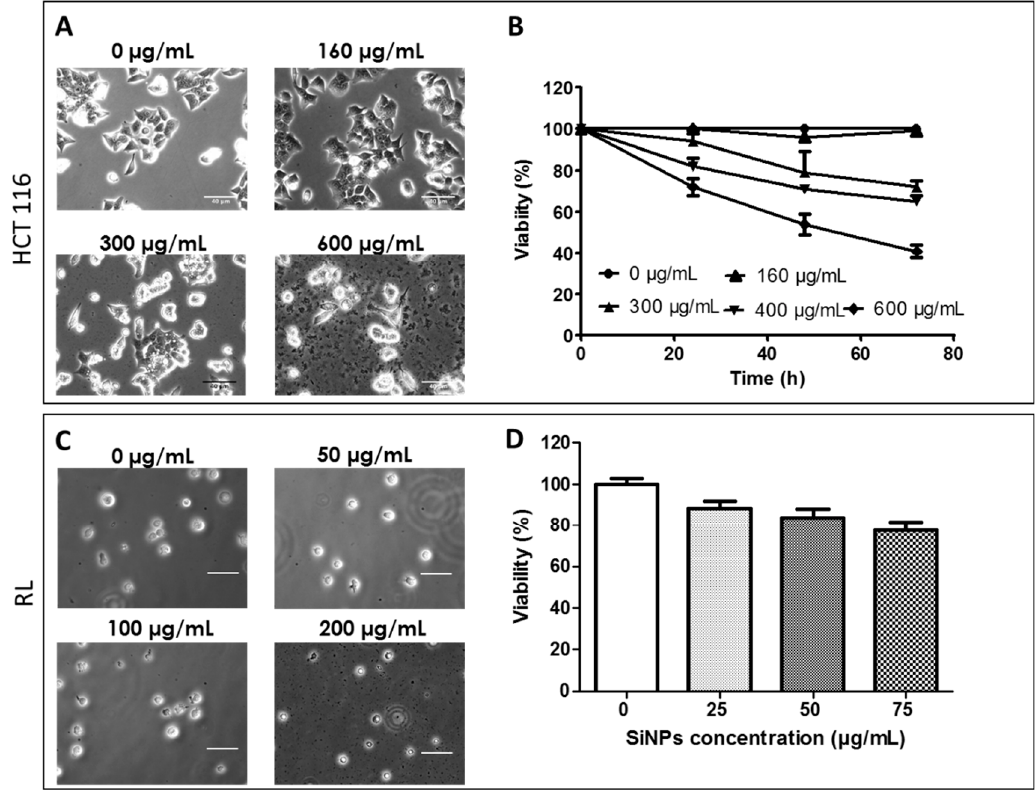
Figure 2. Comparison of cell proliferation in presence of increasing LumiLys 650 NPs concentrations. HCT-116 and RL cells were incubated in the presence of increasing concentrations of LumiLys 650. ( A , C ) Contrast phase micrographs of ( A ) HCT-116 and ( C ) RL cells as a function of SiNPs concentration at 24 h. ( B , D ) Percentage of viability for various concentrations of SiNPs for ( B ) HCT116 as a function of time and ( D ) RL cells 24 h after incubation. Histograms represent the mean +/ − S.D. of three independent experiments.